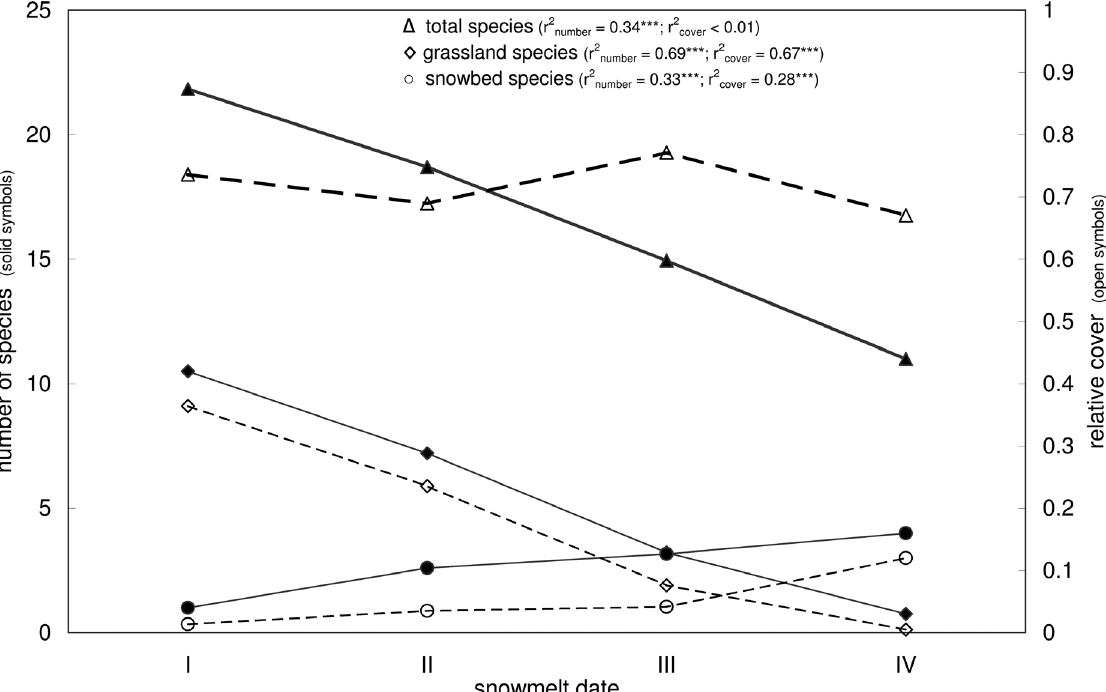
Fig. 1. Number of species (solid symbols) and relative cover (open symbols) for all species, and alpine grassland species and subordinate snowbed species separately, along the snowmelt gradient. Species groups: total species ( ∆ ), alpine grassland species (i.e. avoiders of late-snowmelt sites; ◊ ), subordinate snowbed species (i.e. snowbed specialists;  ) *** = p < 0.001. n for snowmelt date I (2 Jun 2003) = 6, II (9 Jun 2003) = 20, III (16 Jun 2003) = 18, IV (23 Jun 2003) = 8. Data from Schöb et al.